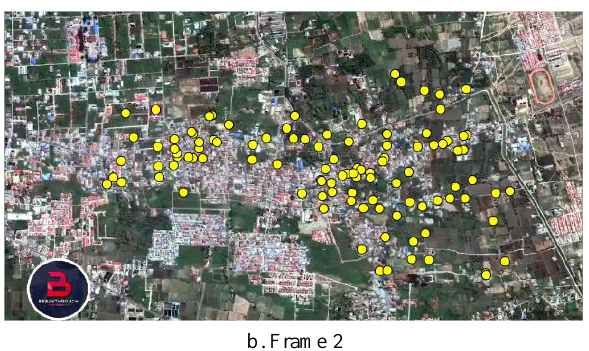
Figure 5. Profiles of feature points on experimental images Meanwhile, different optical flow estimation results generated by 7 state-of-the-art methods and FlowNet 2.0 are compared by using two indexes of RMSE and Mean Value and the results are shown in Table 1. A comparison of RMSE data in horizontal and vertical direction shows that RMSE values in vertical direction of all optical flow estimation methods are significantly lower than their counterparts along the horizontal direction, wherein the values are at least 0.1 lower than their horizontal counterparts. Along the horizontal direction, all the RMSE of the classic optical flow estimation methods have values of 0.29, while the FlowNet 2.0 method has a horizontal RMSE value of 0.30 and the basic HS method has a slightly higher horizontal RMSE value of 0.31. The vertical RMSE of the optical flow estimation methods have values that range from 0.11 to 0.18, where FlowNet 2.0 has the lowest value of 0.11 and the HS method